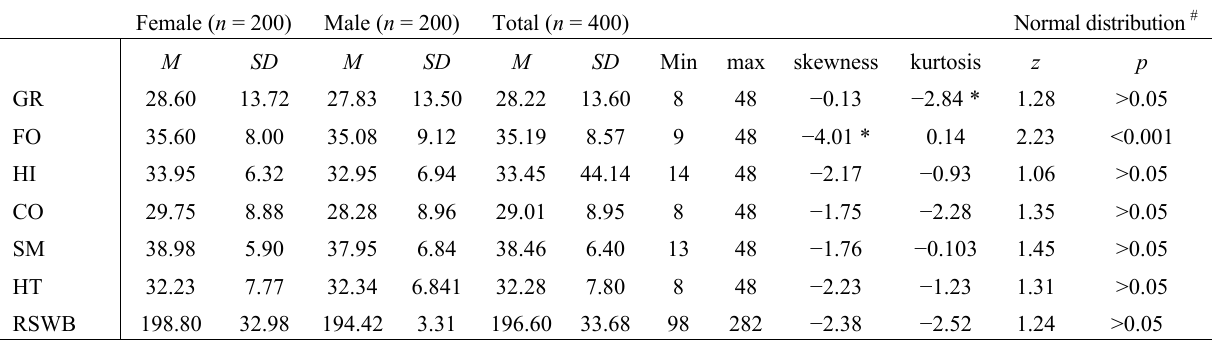
Table 1. Descriptive statistics of the English version of the Multidimensional Inventory of Religious/Spiritual Wellbeing (MI-RSWB-E; n = 400). Female ( n = 200) Male ( n = 200) Total ( n = 400) Normal distribution